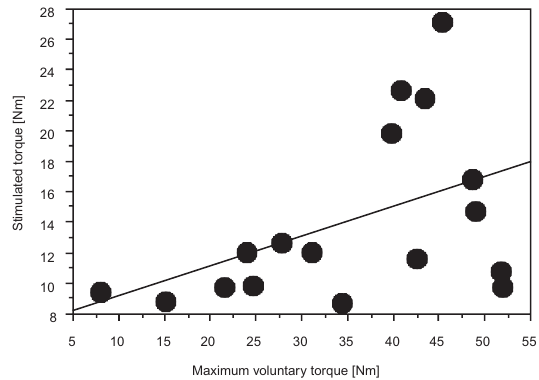
Figure 4 Correlation between maximum voluntary muscle torque of the ankledorsiflexors and torque evoked by peroneus nerve stimulation in control population. The cor- relation was R = 0.5 for overall stimula- tion (single- to quadruple-pulse nerve stimulations) with 3-pulse stimula- tion eliciting the highest correlation, R = 0.7. Nm = Newton-